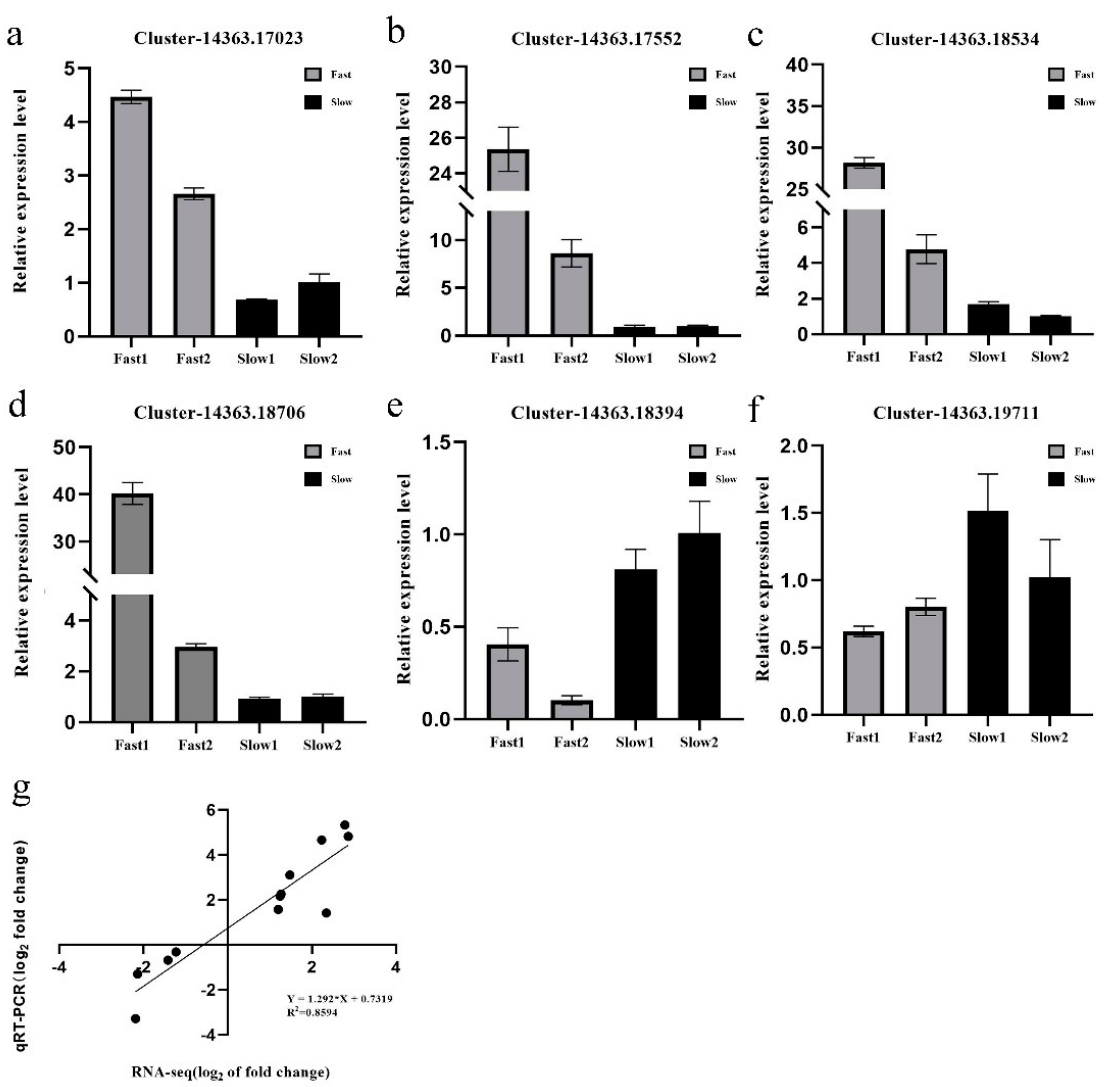
Figure 5. Validation of RNA-Seq data. Verification of the expression level of the selected eight DEGs from RNA − Seq data through RT-qPCR: ( a ) Cluster_14363.17023, ( b ) Cluster_14363.17552, ( c ) Cluster_14363.18534, ( d ) Cluster_14363.18706, ( e ) Cluster_14363.18394, ( f ) Cluster_14363.19711. Error bars indicate the standard error as mean + SD. The x axis represents the relative expression level, and the y -axis represents cultivars. ( g ) Correlation coefficient of gene expression between qRT − PCR analysis and RNA-Seq data.